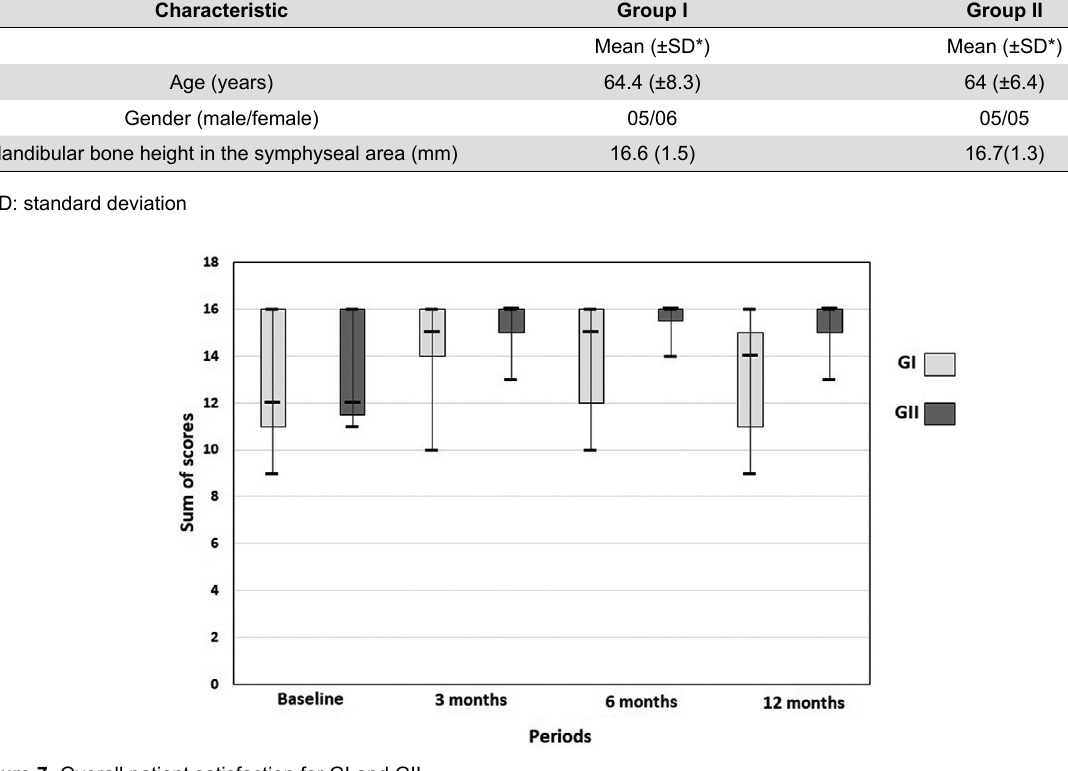
Figure 7- Overall patient satisfaction for GI and